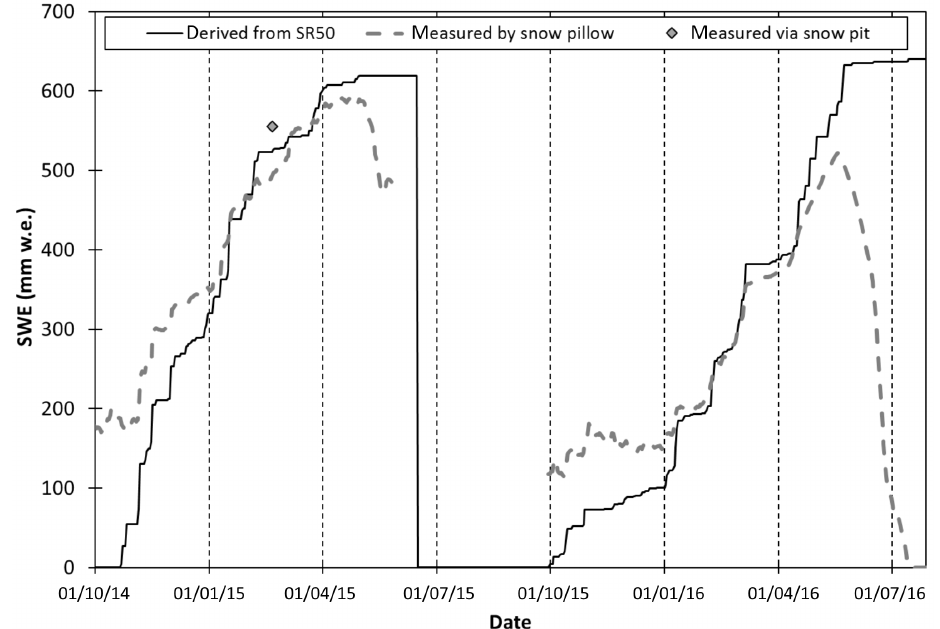
Figure 4. Daily SWE data derived from snow depth measured by Campbell SR50 (using the new snow density of 149kgm − 3 ) and measured by snow pits and snow pillow from October 2014 to July 2016. The dates shown are dd/mm/yy.